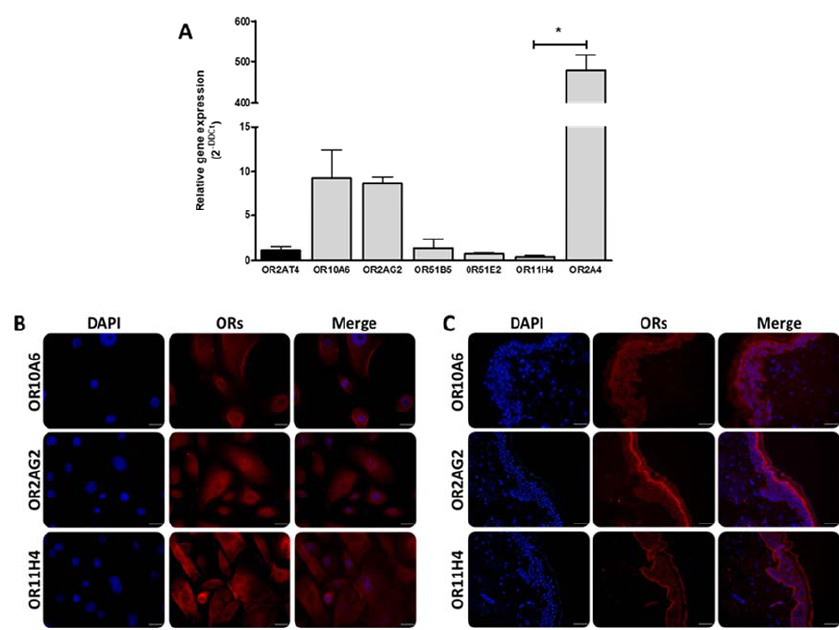
Figure 1. Olfactory receptor expression in NHEK cells. ( A ) mRNA expression of olfactory receptors was measured using RT-qPCR ( n = 3). Data are presented as mean ± SEM. Significance was calculated using the Kruskall–Wallis test (* p ≤ 0.05). ( B ) Immunodetection of olfactory receptors in human keratinocytes. Scale bar: 15 µ m. ( C ) Immunohistochemistry of olfactory receptors in human skin explants. Scale bar: 50 µ m (for a scale bar: 15 µ m, see Supplementary Materials Figure